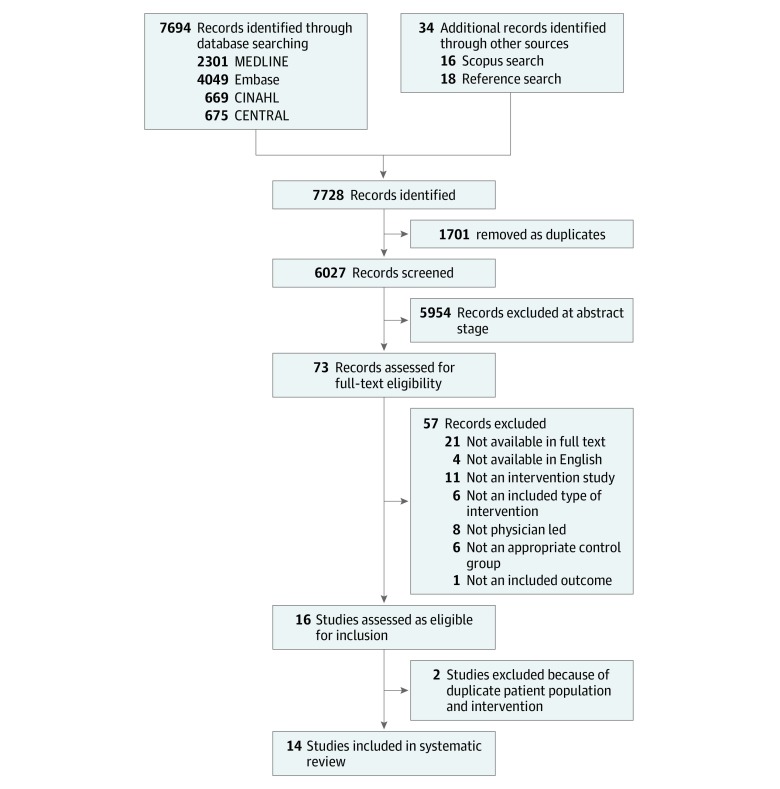
Study Selection Flowchart